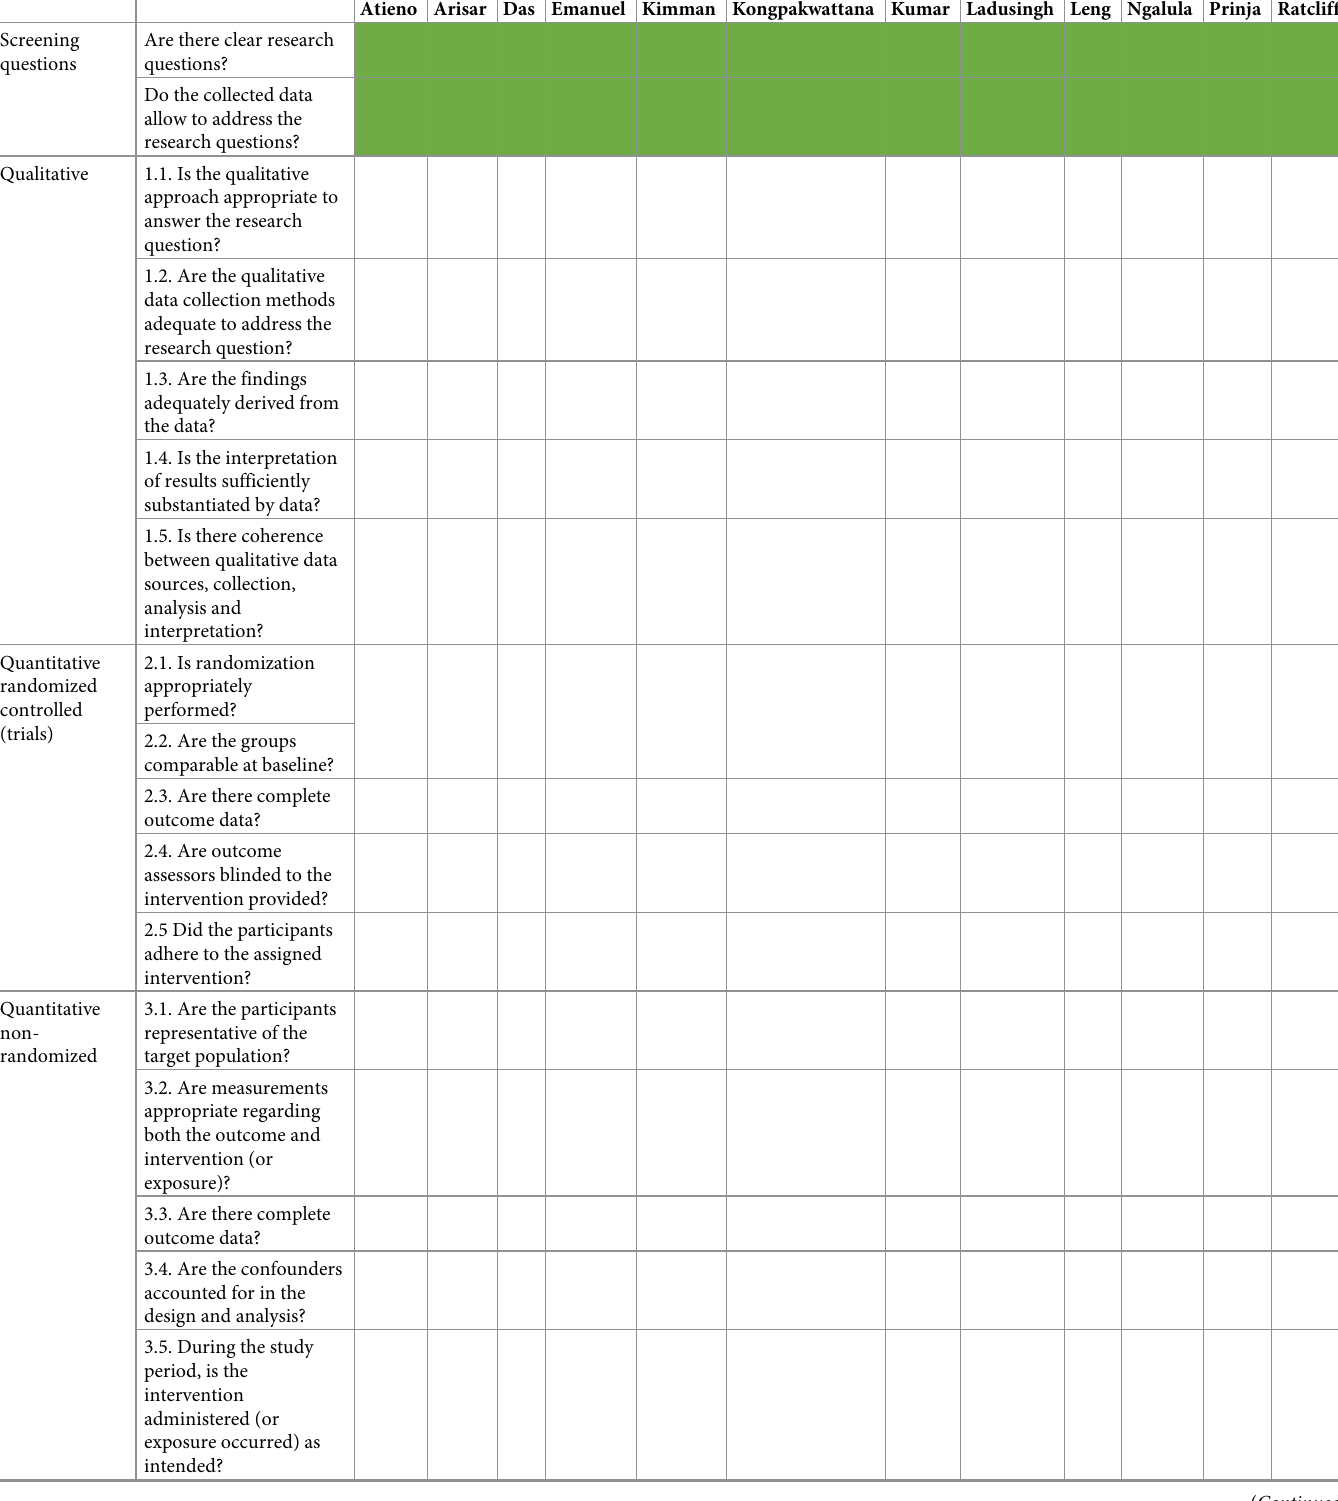
Table 2. MMAT quality